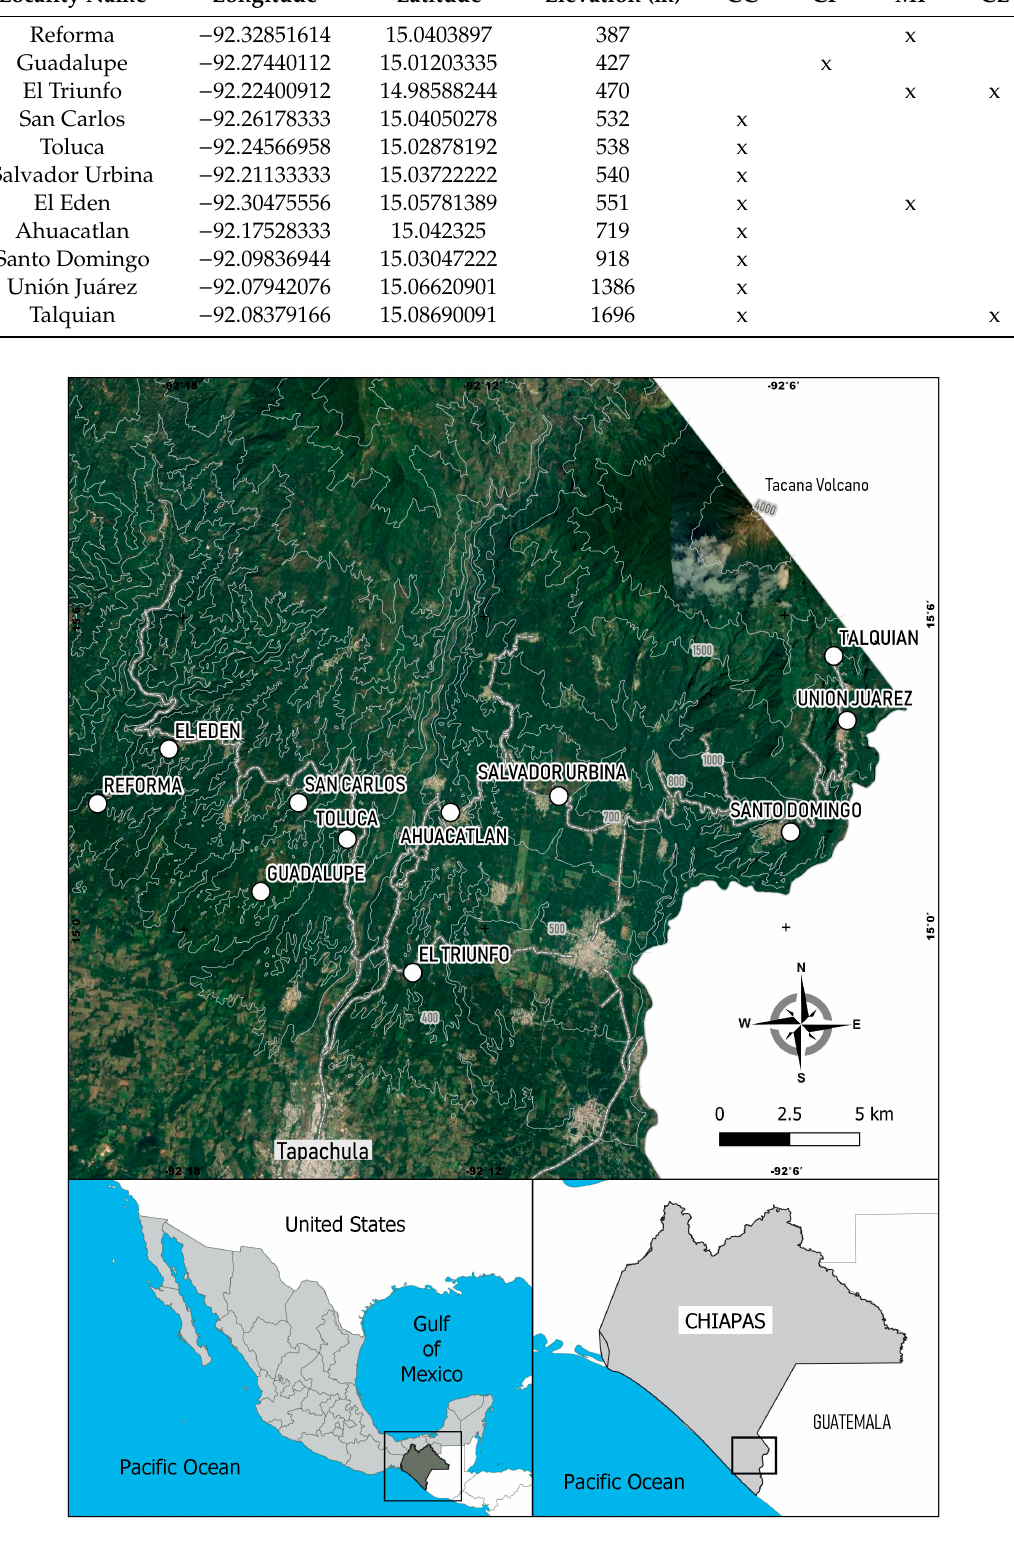
Figure 1. Map of sampling sites of Anastrepha ludens in Soconusco, Chiapas, Mexico.